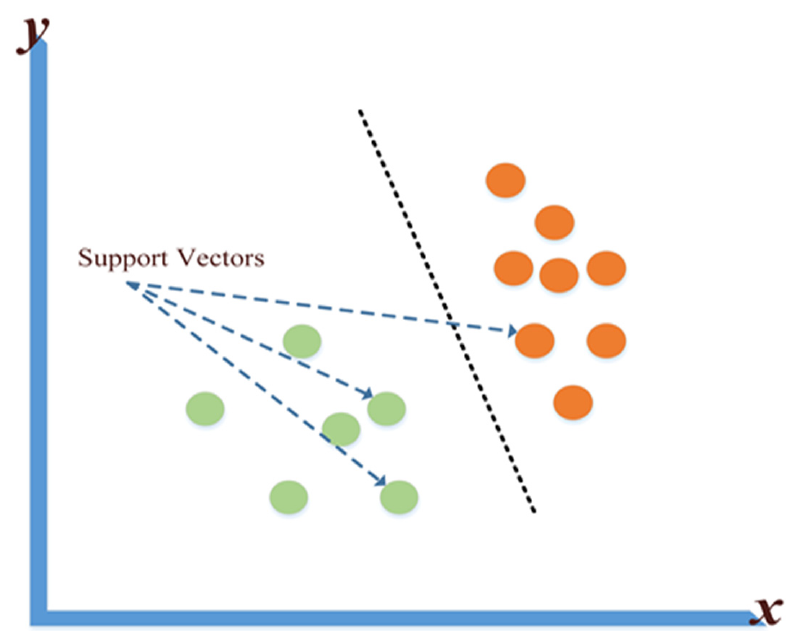
Figure 8. The SVM Figure 8. The SVM method.